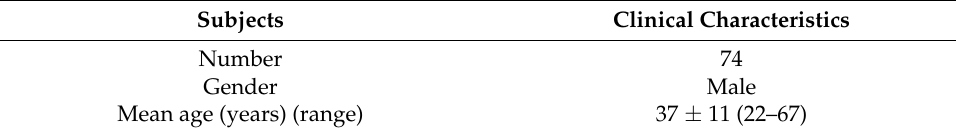
Table 1. The characteristics of included